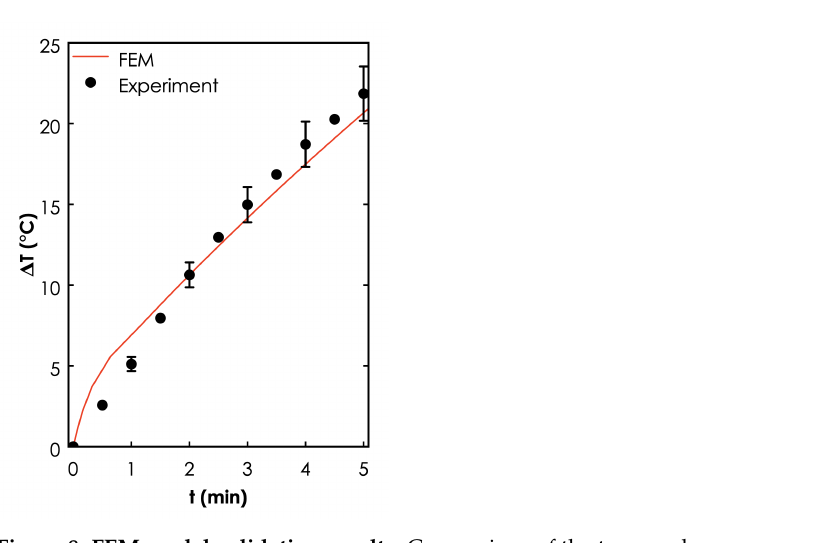
Figure 8. FEM model validation results . Comparison of the temporal response curves for the FEM predictions and experimental data for a 5 min irradiation of a cubic photoseed ( φ au = 10% wt.) in 0.5 mL of distilled water contained in a 1.5 mL Eppendorf